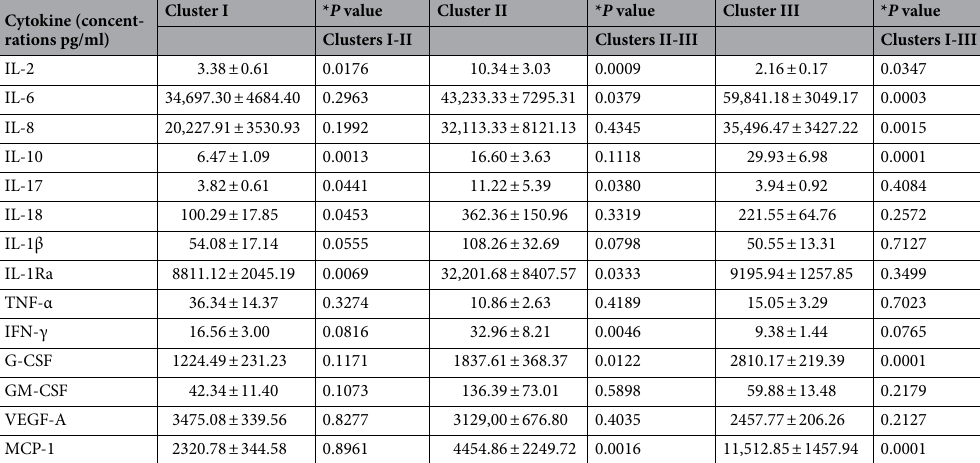
Table 2. Parameters of cytokine production (pg/ml) by the cultured IBC-NST biopsy samples in groups (Clusters I-III), yielded by multivariate cluster analysis based on similarity of the immunological profiles. * P significance of differences between groups, in clusters, evaluated by the non-parametric Mann–Whitney. U-test. Data are presented as a mean ± standard error of the